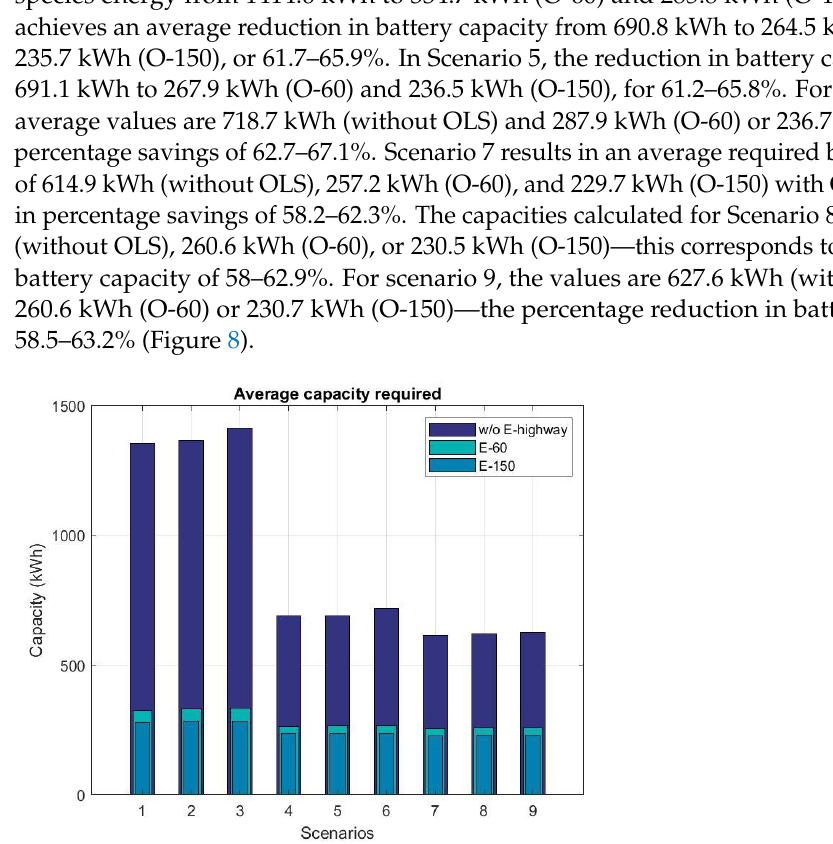
Figure 7. Minimum required capacity—350 kW charging stations—scenarios 7–9 (own illustration).